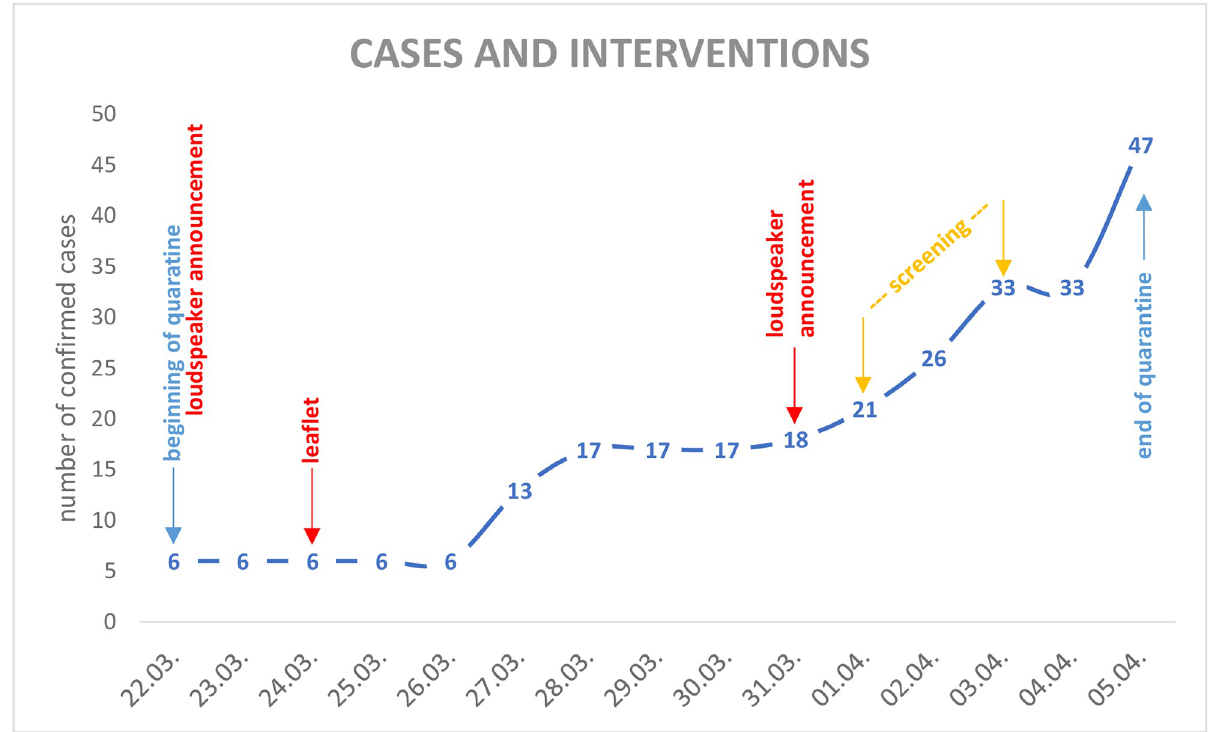
Fig 1. Overview of the confirmed cases of SARS-CoV-2 in Neustadt am Rennsteig and the interventions of the local authorities. The beginning of the community quarantine was announced via loudspeaker as well as the screening of every inhabitant (symptomatic or asymptomatic) in the second week. The third day of quarantine (24.03.2020) a leaflet was handed out with all the necessary information. You can find the issued order and the leaflet in the Supplementary Material. [number of confirmed cases according to https://www.ilm-kreis.de/Landkreis/Ver%C3%B6ffentlichungen/ Pressearchiv/index.php?ModID=255&object=tx%2C2778.5.1&La=1&NavID=2778.25&text=&kat=&monat=202003&jahr= (accessed: 28.04.2020)].